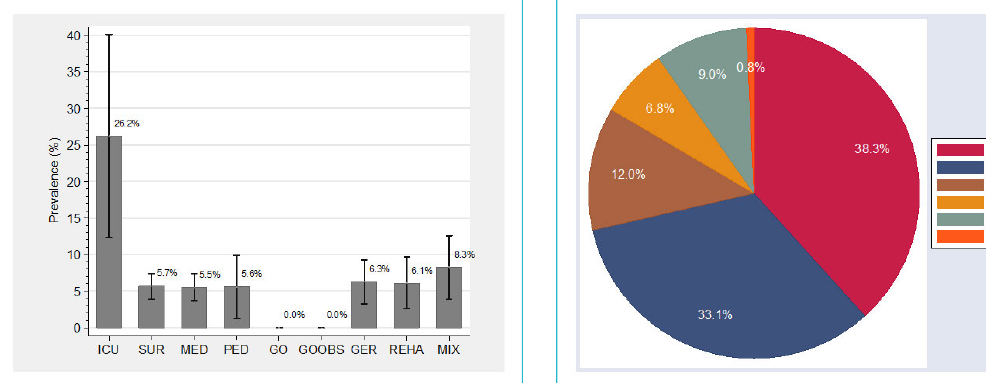
Table 3: Antimicrobial use – multicentre point prevalence survey, Switzerland 2016.